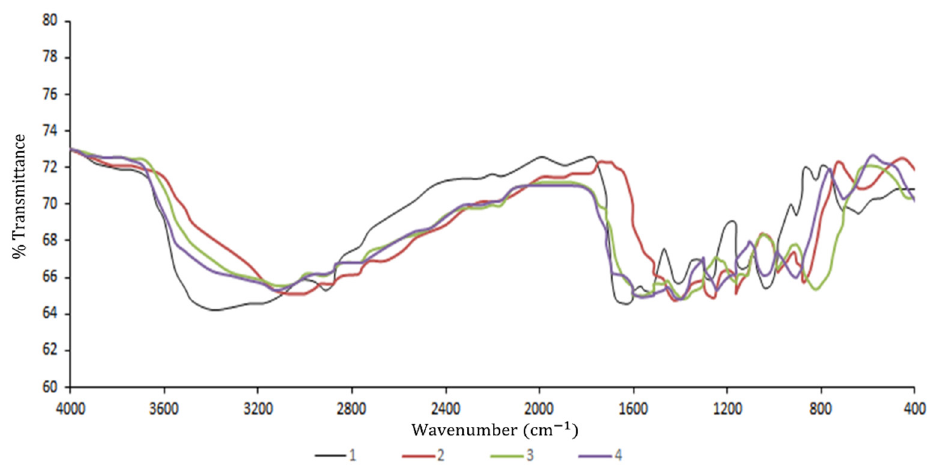
Figure 4. FTIR spectra of the control film (1), control film containing 1% CEO (2), control film containing 2% CEO (3), and control film containing 3% CEO (4).